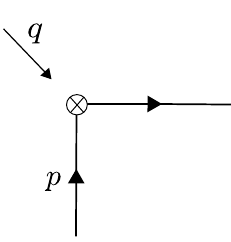
q ) and two fermions ψ ( k ) and −